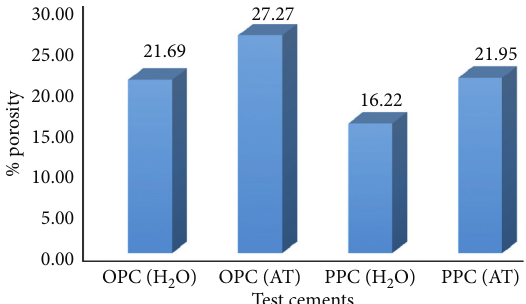
Figure 7: Porosity of control and microbial-treated test cements.